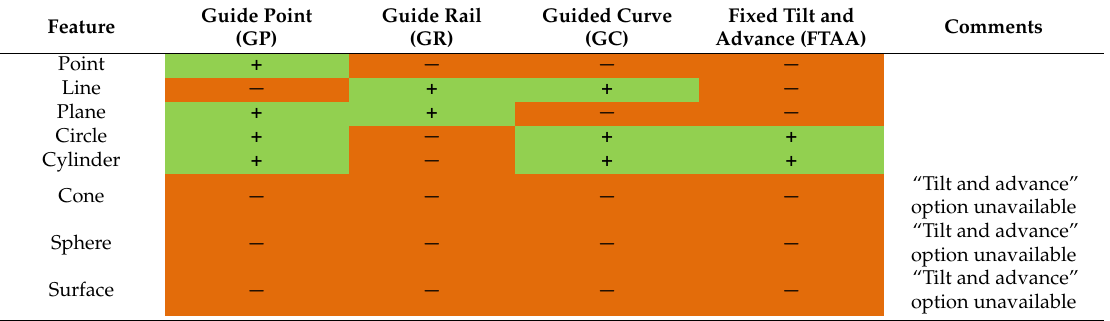
Table 1. Path control algorithms that can be applied for measurement of specified features.